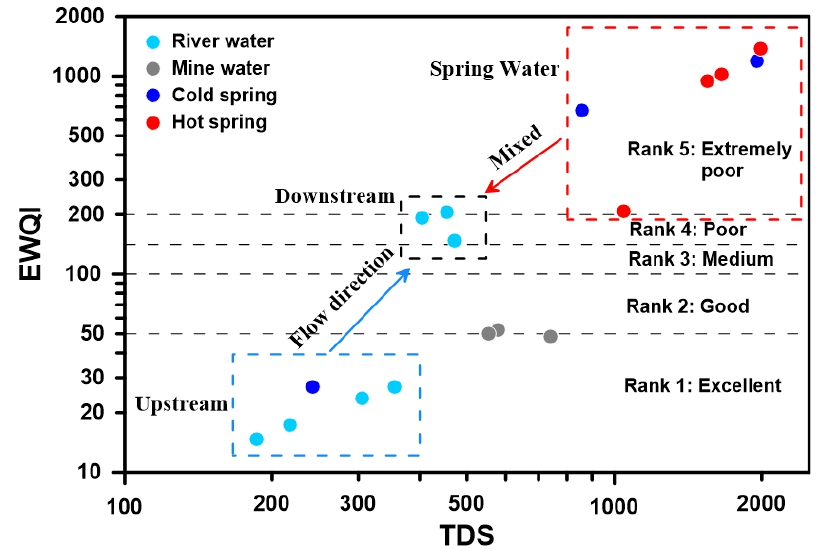
Figure 11. Correlation diagram between EWQI and TDS.